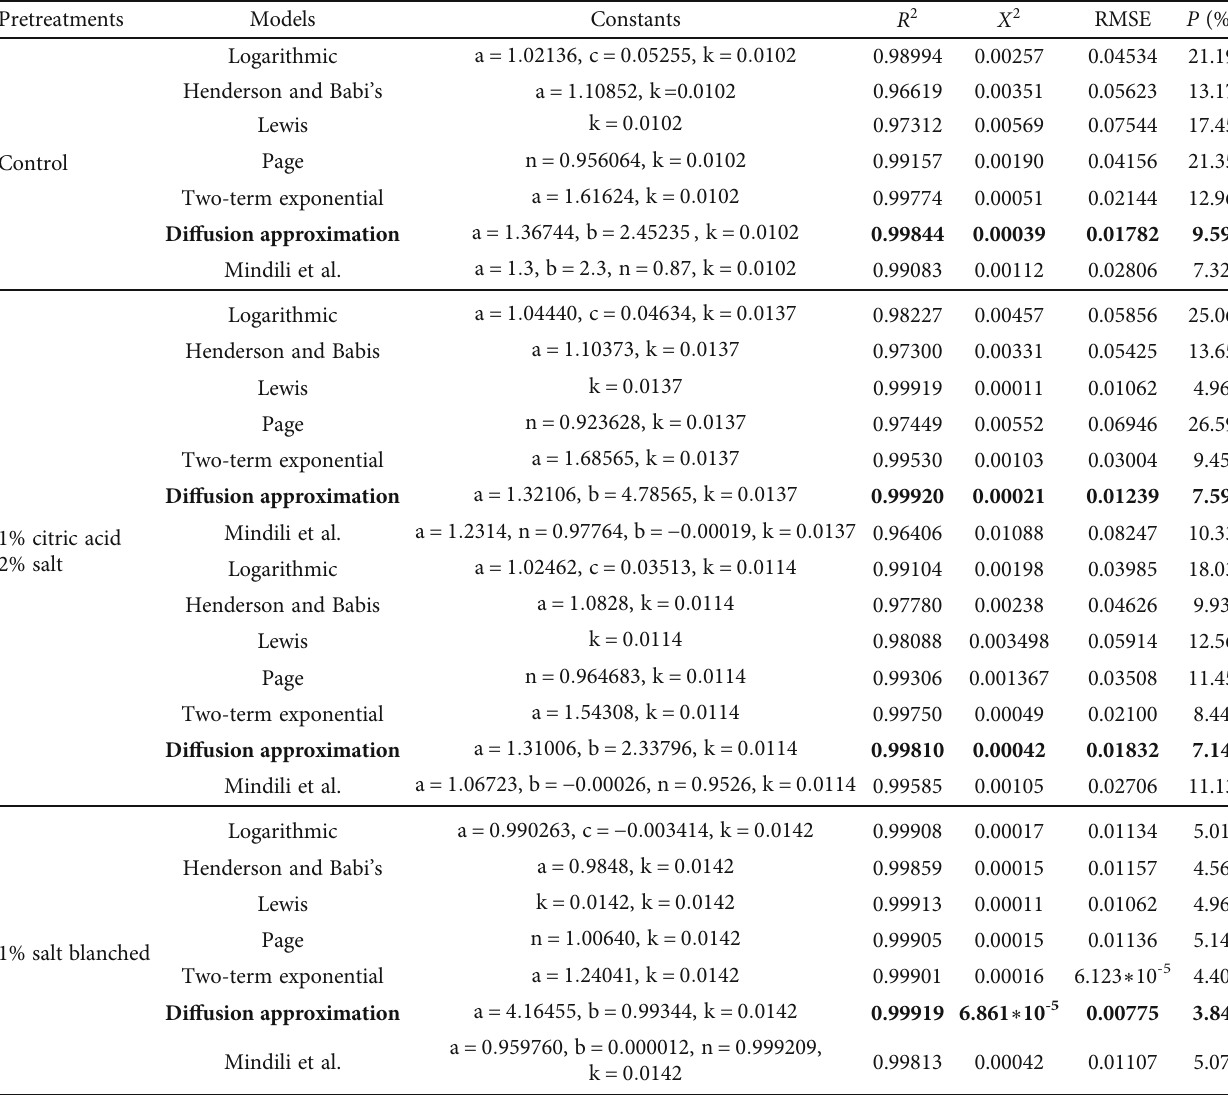
Table 4: Curve fi tting criteria for the various mathematical models and parameters for pumpkin slice dried at zone III.